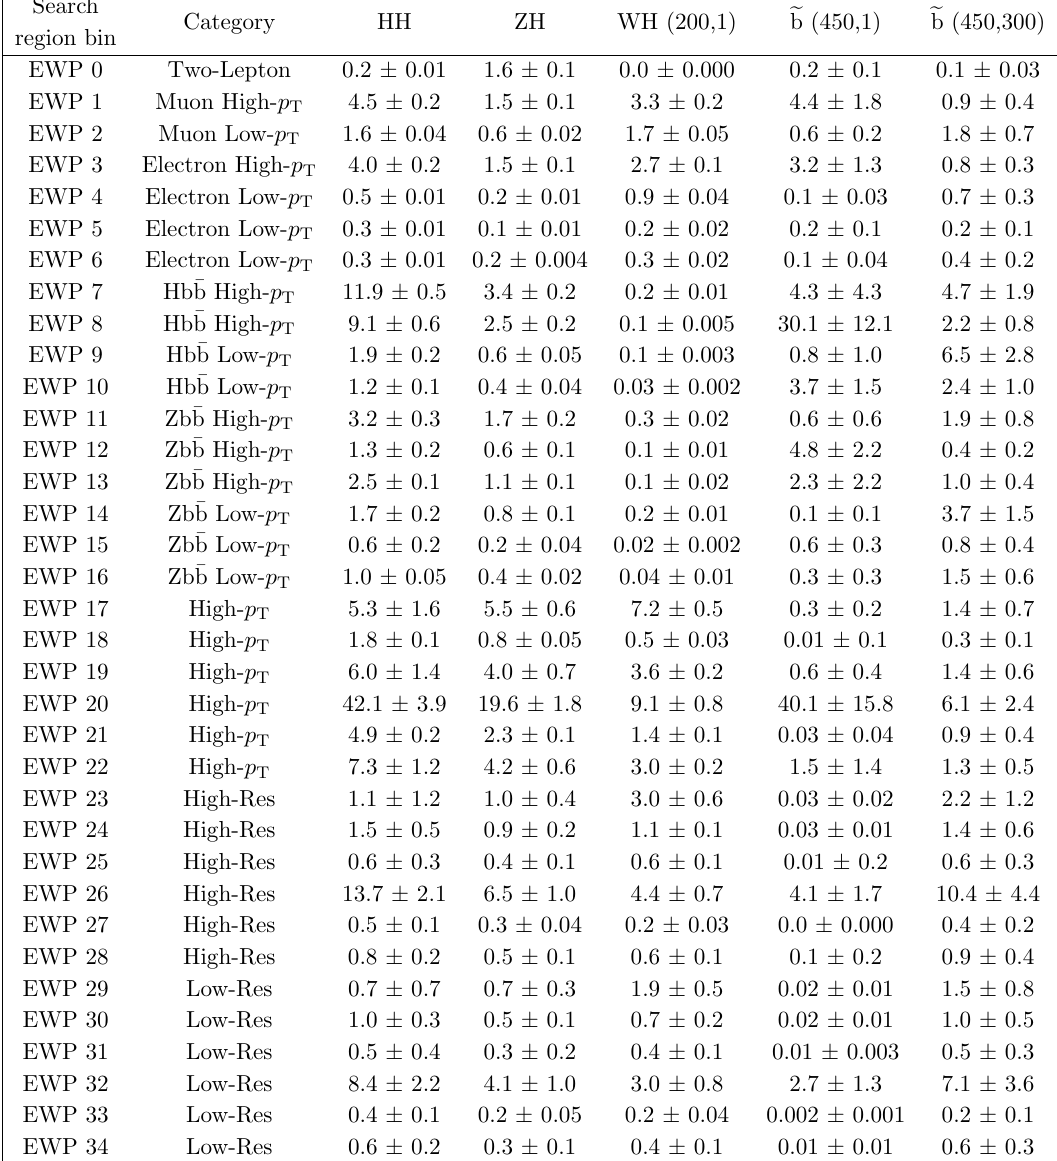
Table 10 . The expected signal yields for the SUSY simpli(cid:12)ed model signals considered are shown for each search region bin of the EWP analysis. The category that each search region bin belongs to is also indicated in the table. The search region bins de(cid:12)nitions are summarized in table 1. The labels for the di(cid:11)erent signal models are explained in detail in the caption of table 8. The resonant background from standard model Higgs boson production is estimated from simulation. The results are interpreted in terms of exclusion limits on the production cross section of simpli(cid:12)ed models of bottom squark pair production and chargino-neutralino production. As a result of the improvements in the event categorization and the larger data set, we extend the mass limits over the previous best results [8] by about 100 GeV for bottom squark pair production and about 50 GeV for chargino-neutralino